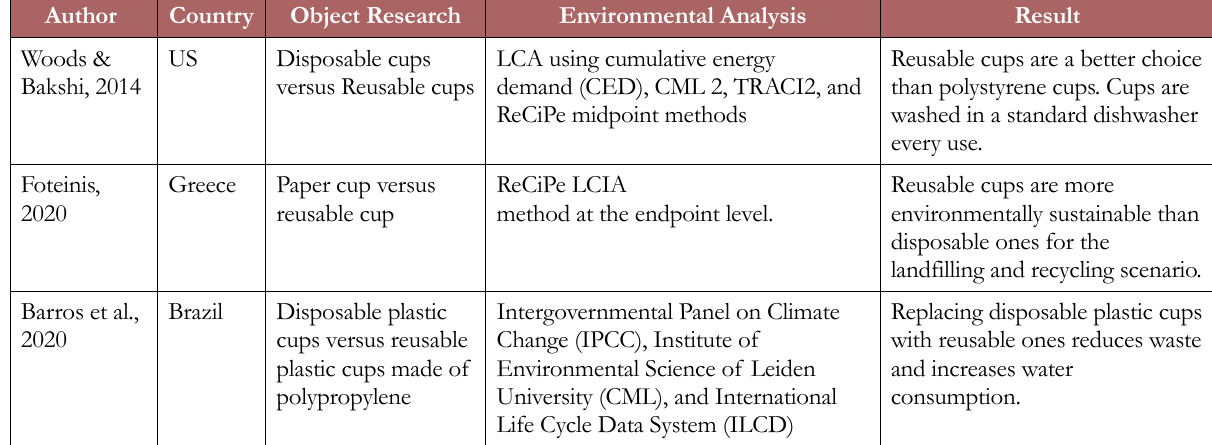
Table 1. Studies about conventional product and its alternative